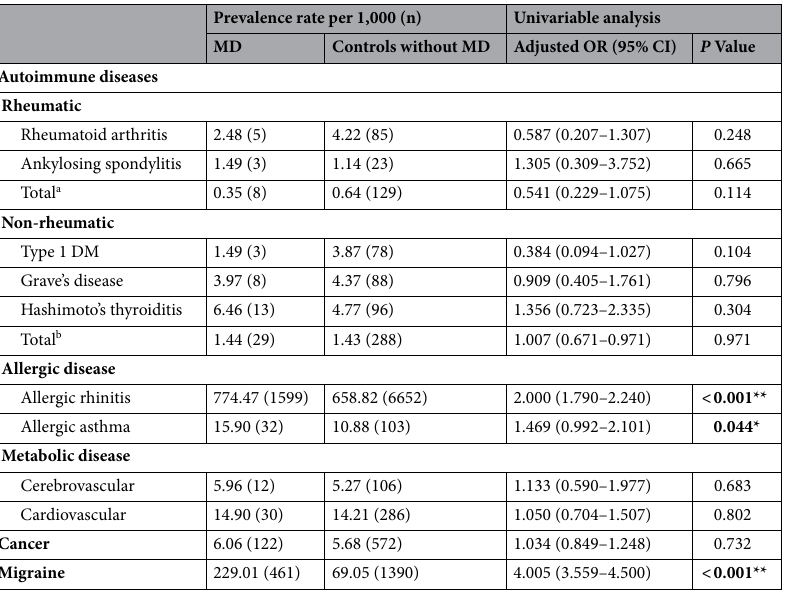
Table 3. Comorbidities of participants with Ménière’s disease. Significant values are in [bold]. a Systemic lupus erythematous, Dermatomyositis/polymyositis, systemic sclerosis, Sjogren’s syndrome, ankylosing spondylitis, rheumatoid arthritis. b Type 1 diabetes mellitus, grave’s disease, hashimoto’s thyroiditis, crohn’s disease, ulcerative colitis, autoimmune hepatitis. MD Ménière’s disease, DM Diabetes